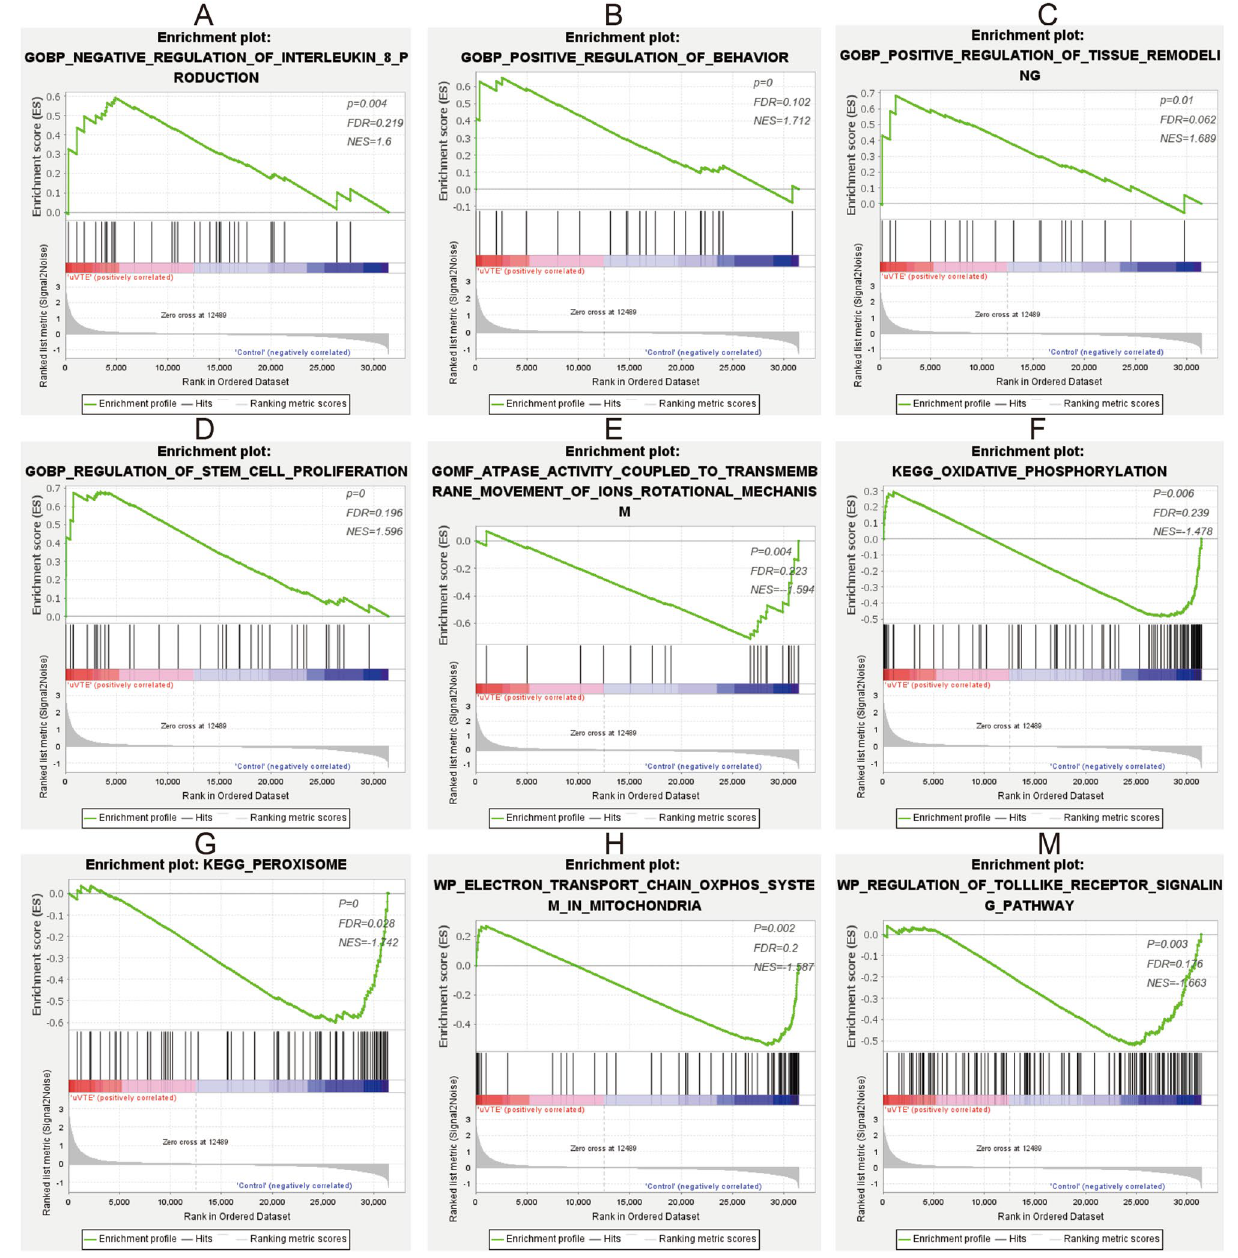
Figure 4. GSEA results of uVTE and control group samples. ( A–E ) GSEA results of reference gene sets regarding GO terms in c5 GO V7.4. symbol. gmt. ( F–M ) GSEA results of reference gene sets regarding pathways in c2 KEGG V7.4. symbol. gmt and c2 wikipathway V7.4. symbol. gmt. GSEA gene set enrichment analysis, NES normalized enrichment score, uVTE unprovoked Venous Thromboembolism, KEGG Kyoto Encyclopedia of Genes and Genomes, Go Ontology, GO. Created with GSEA soft_4.1.0 (http:// www. gsea- msigdb. org/ gsea/ downl oads.